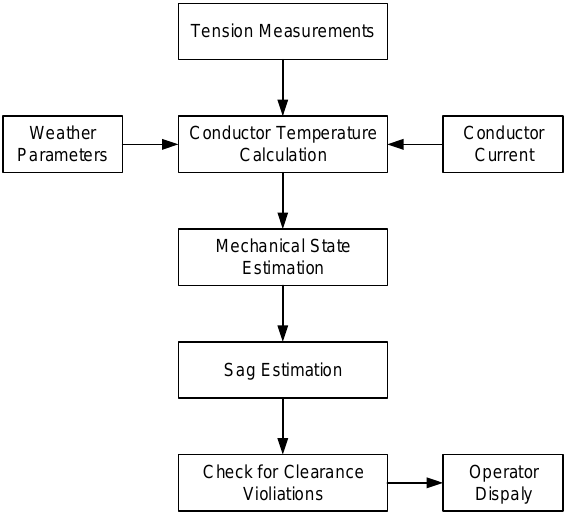
Figure 5. The sag estimation process reproduced from [26].